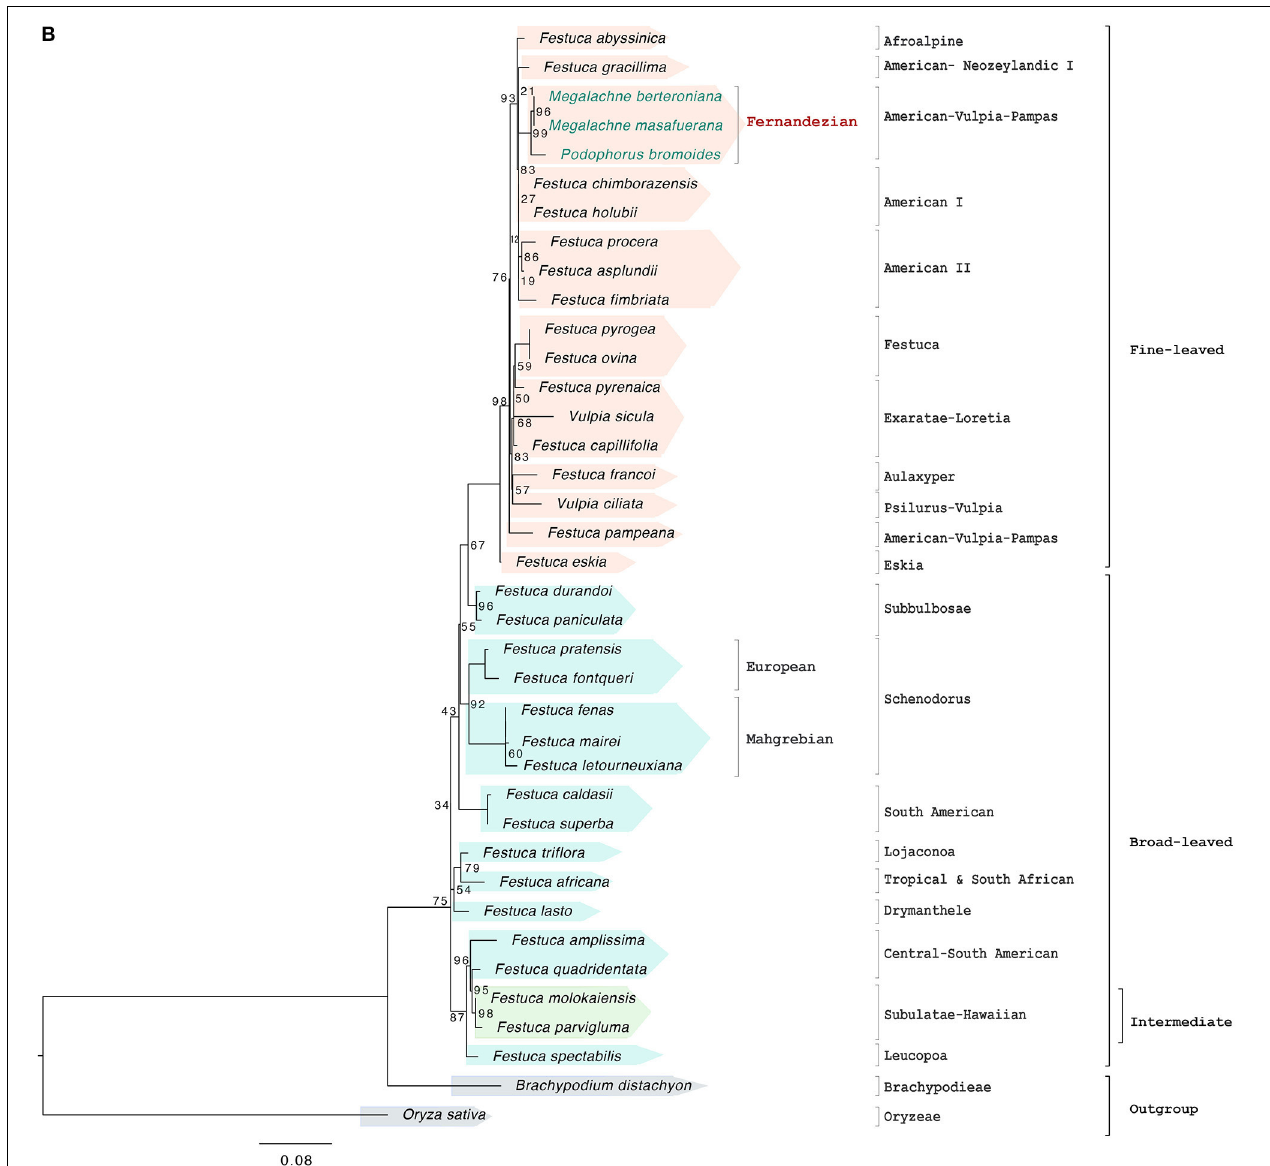
FIGURE 3 | Maximum likelihood nuclear rDNA cistron (A) and ITS (B) trees constructed with IQTREE showing the relationships among the studied Fernandezian and Loliinae grasses. Oryza sativa was used to root the trees. Numbers indicate branches with UltraFast Bootstrap supports (BS) < 100%; the remaining branches have 100% BS